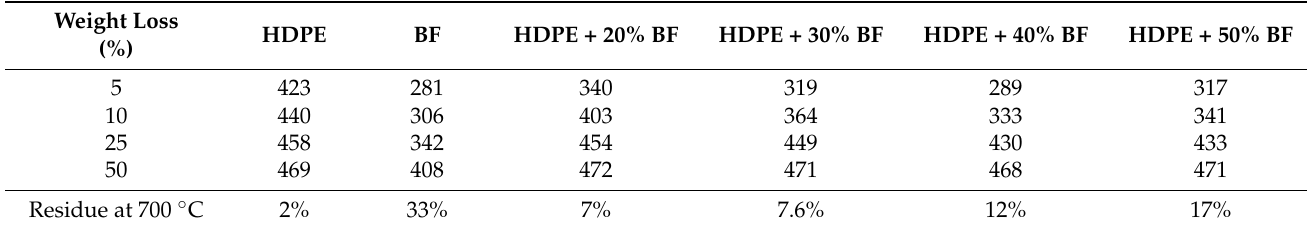
Table 2. Onset temperatures for 5%, 10%, 25%, and 50% of weight loss and residue at 700 ◦ C. Weight